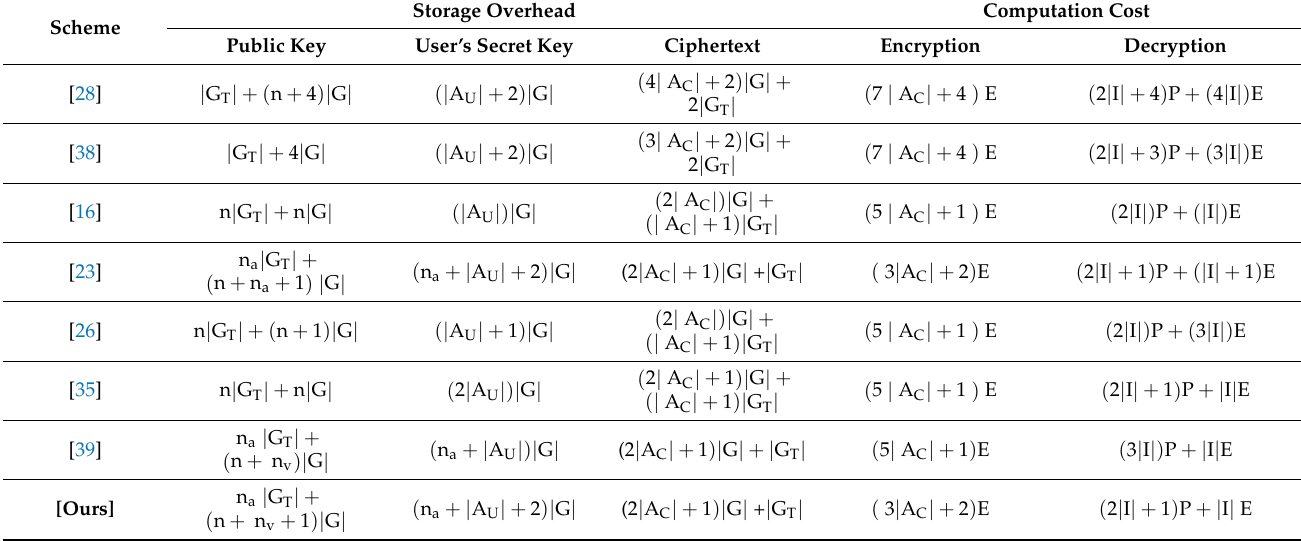
Table 2. Storage and computation cost